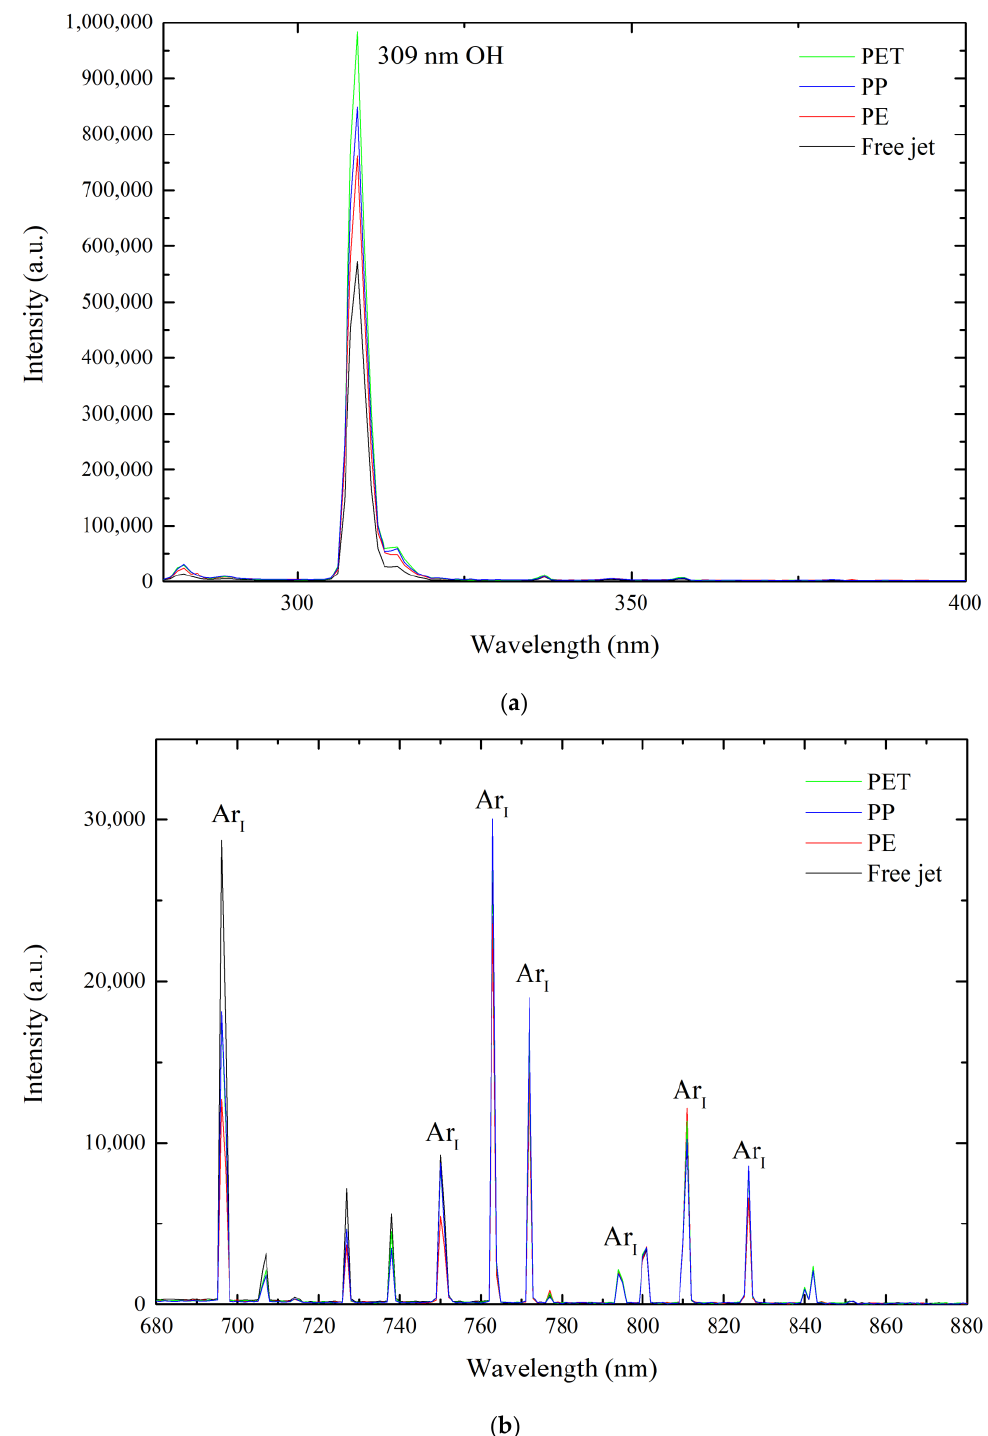
Figure 4. OES results for the argon-based APPJ in ( a ) wavelength 280 – 400 nm; and ( b ) wavelength 680 – 880 nm.